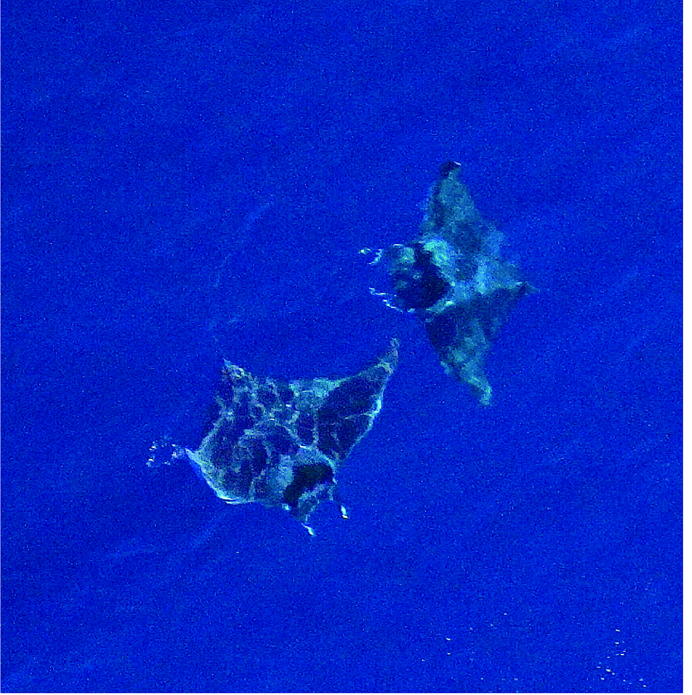
Fig 3. A pair of giant devil rays Mobula mobular photographed from the air. The general appearance of the body, the paired cephalic fins, the long tail and the dorsal colouration are diagnostic (photo by Elio Filidei,